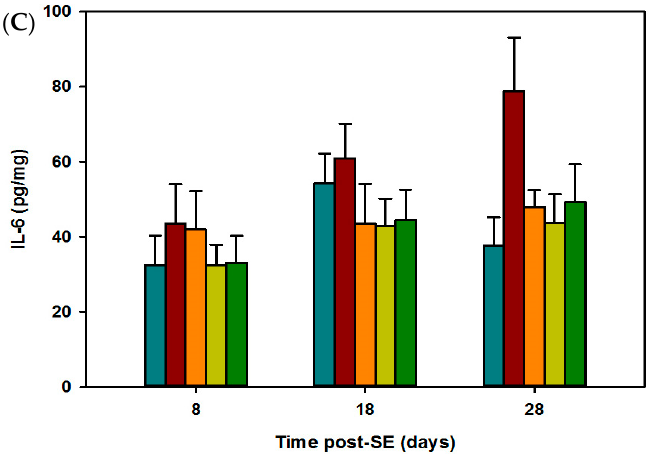
Figure 2. Effect of thalidomide (TAL) and topiramate (TOP) on hippocampal proinflammatory cy- tokines quantified 8, 18 and 28 days after status epilepticus (SE). ( A ) TNF- α concentration of ( B ) IL- 1 β concentration and ( C ) IL-6 concentration. Each bar represents the mean + S.E.M. of 6 animals per group. Different capital letters denote p ≤ 0.05 among times within treatments, lowercase letters designate p ≤ 0.05 among treatments within times, two-way ANOVA followed by the Student-New- man-Keuls post-hoc test. C, control group. The tables show the results of statistical analysis. Additionally, Pearson correlations were performed among the variables, to know if increases in the hippocampal concentrations of TNF- α , and IL-1 β are correlated with the latency to the first seizure or number and duration of seizures. The analysis showed three significant correlations (Figure 3). In the TAL50 group on day 8, the latency to the first seizure and TNF- α concentration were significantly correlated (r = − 0.83, p = 0.04). It shows that if TNF- α concentration increases, the latency to the first seizure is reduced (Figure 3A). The second correlation was between the number of seizures and TNF- α concentration in the TOP group on day 28 (r = 0.83, p = 0.04, Figure 3B). It shows that if TNF- α concen- tration increases, the number of seizures also increases. The third correlation was between the duration of seizures and IL-1 β concentration in the TAL25 group on day 18 (r = 0.86, p = 0.03; Figure 3C). This indicates that if IL-1 β concentration increases, the seizure dura- tion increases too.